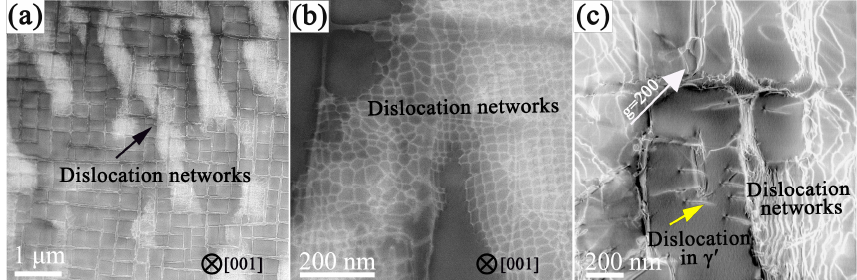
Figure 8. TEM-BF images showing dislocation configurations of an alloy at 980 °C under Δ ε t /2 = 1.0%: ( a ) distribution of the dislocations; ( b ) formation of dislocation networks; and ( c ) dislocation in the γ′ phase.